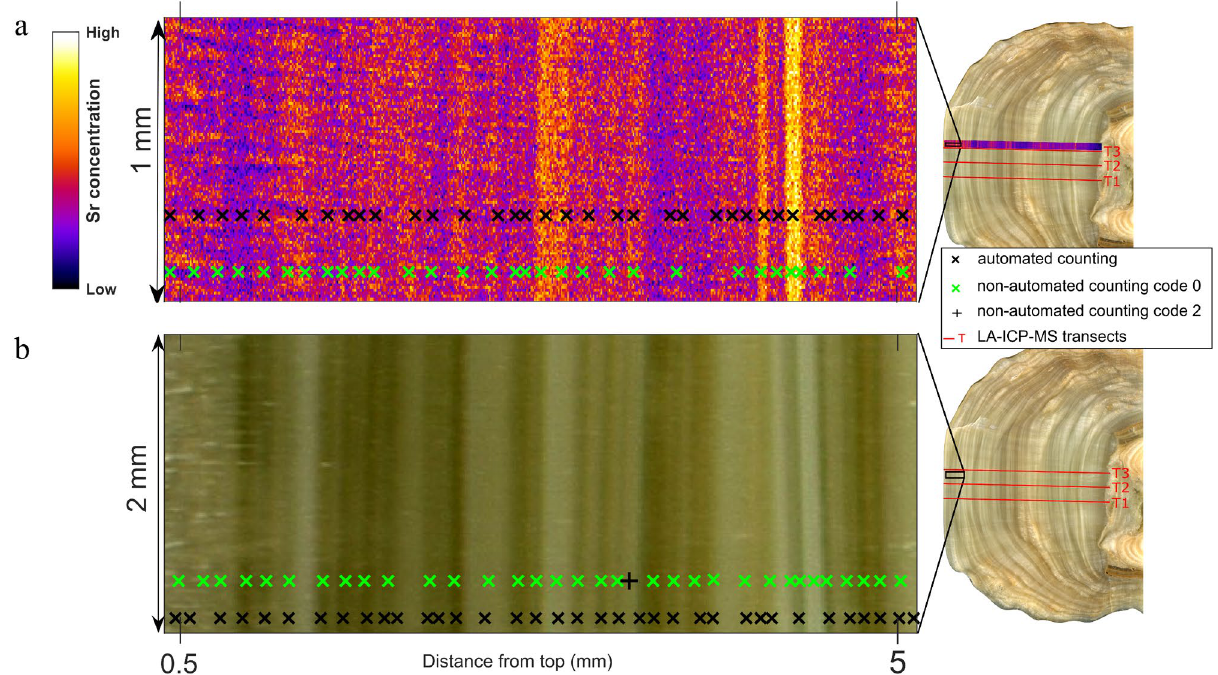
Figure 1. Locations of laminae on ( a ) the Sr synchrotron µXRF map, and ( b ) the high resolution scan of stalagmite, as identified by automated and non-automated counting in the topmost section of the